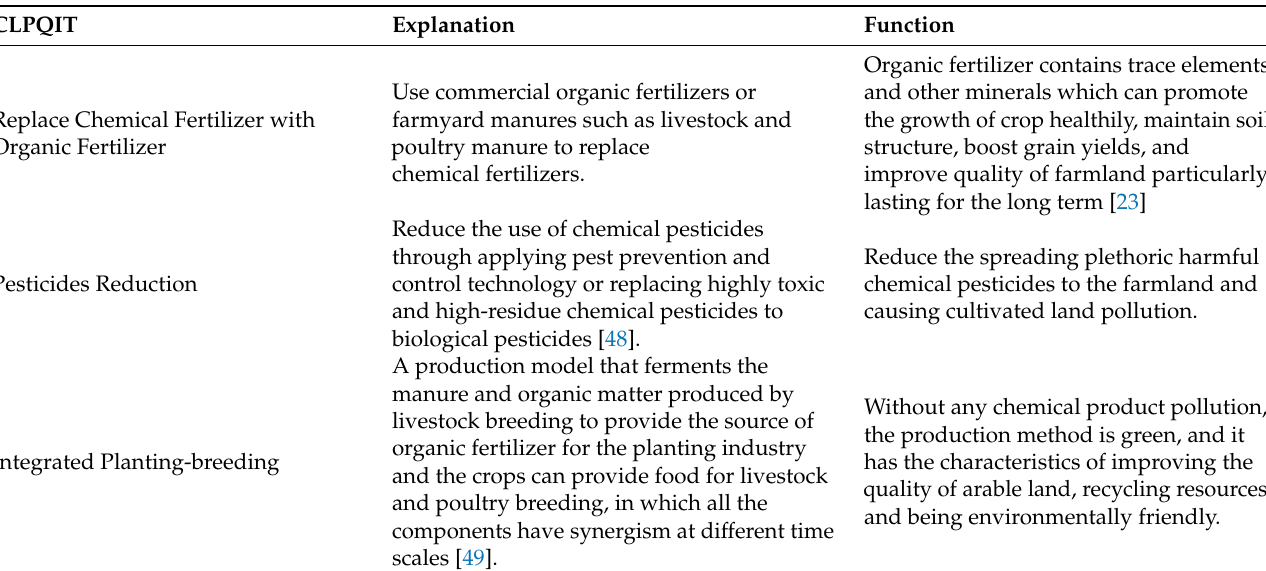
Table 1. Explanation and Function of